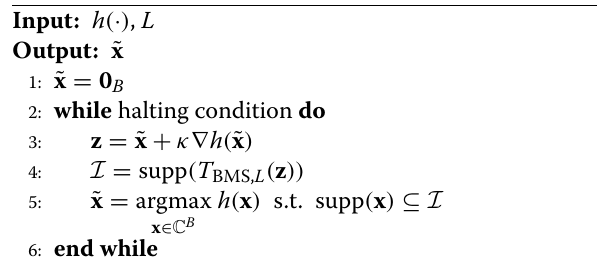
Algorithm 3 BMSGraHTP